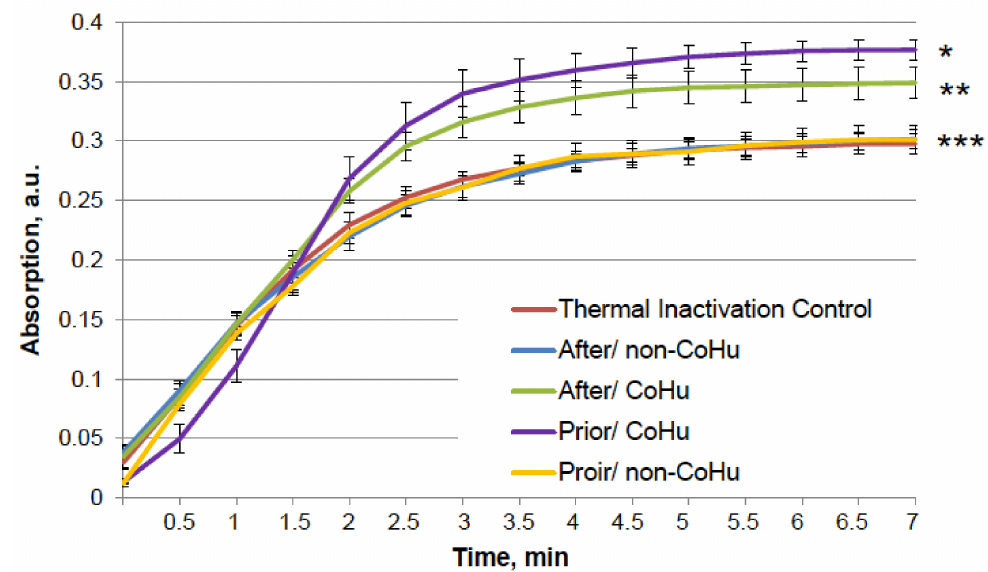
Figure 2. The effect of CoHu on thermally inactivated HRP. Data presented as mean arbitrary units of 8 measurements ± SD. Prior/non-CoHu means that samples were treated with non-CoHu before thermal inactivation. After/CoHu means that samples were treated with CoHu mode after thermal inactivation. Prior/CoHu means that samples were treated with CoHu before thermal inactivation. *, ** and ***—Lines with different superscripts differ significantly ( p <